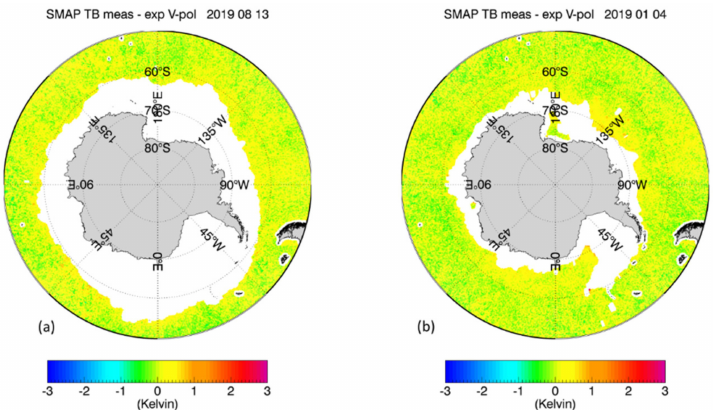
Figure 8. SMAP V-pol TB biases for the test cases from Figures 1 and 2 after discriminant and NN flagging. The resulting observations lie all within sea-ice Zone 0. ( a ) 13 August 2019; ( b ) 4 January